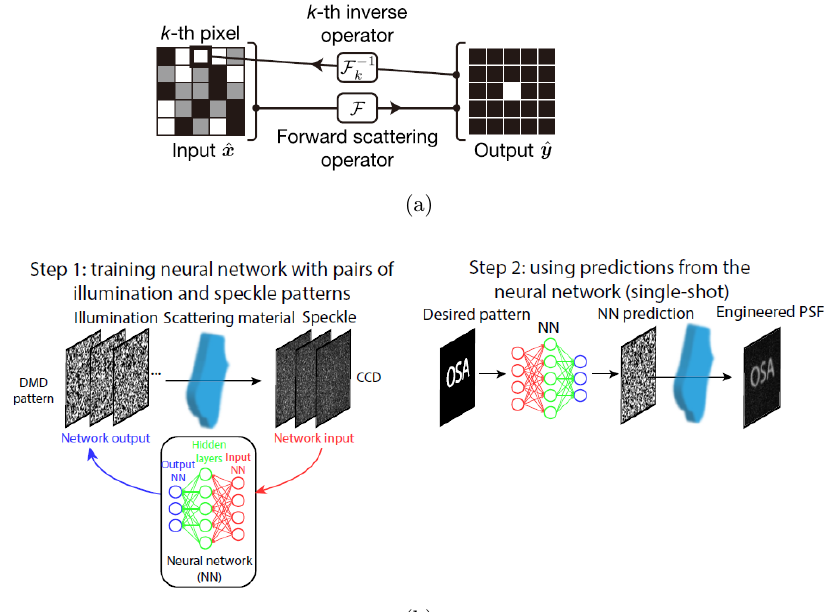
Fig. 1. Illustration of AI-assisted coherent light control through scattering media. (a) Light focusing through a scattering medium assisted by machine learning. The input pattern was stepwise optimized with the trained inverse scattering operator, and the target output pattern can be reproduced through the scattering medium and (b) Two-step NN-assisted WFS for controllable light delivery through scattering media. The illumination and the corresponding speckle patterns are formed into pairs to train the NN, with the speckle patterns as the input and the DMD patterns as the output. The trained network is then used to predict a DMD pattern that can generate a desired pattern after the medium. The prediction is subsequently displayed on the DMD, resulting in a pattern identical or very similar to the desired one through the scattering medium. Reproduced from Refs. 28 and